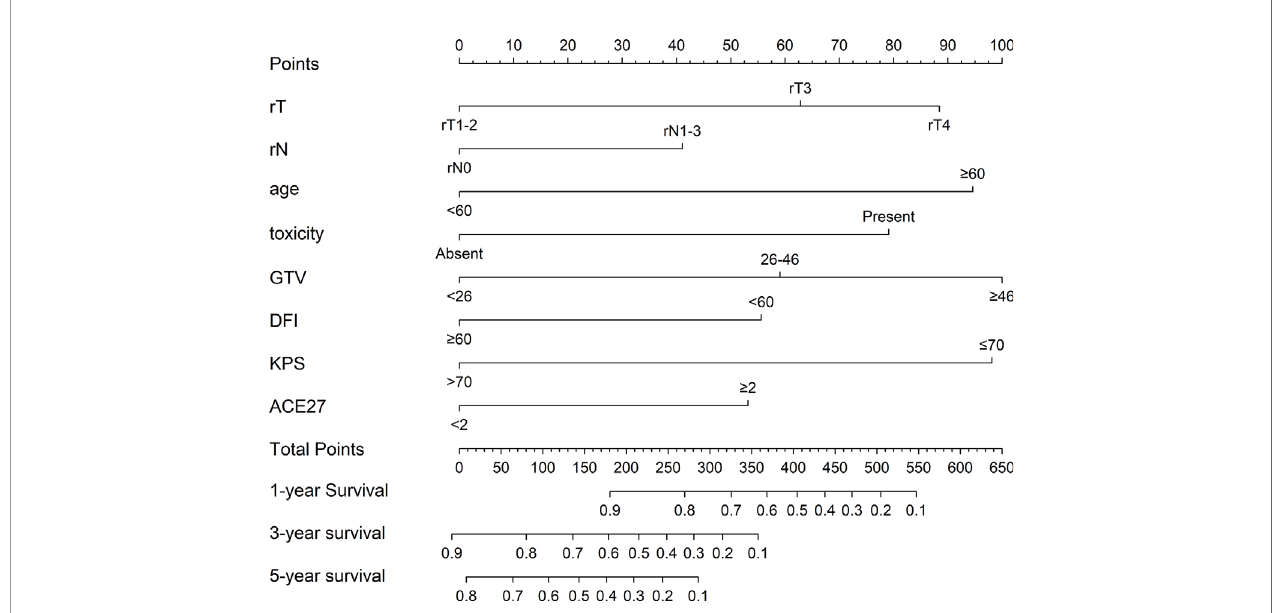
FIGURE 3 | Prognostic nomogram for locally recurrent nasopharyngeal carcinoma (lrNPC) patients: a line was drawn straight down to predict the 1-, 3-, or 5-year overall survival. rT, recurrent T stage; rN, recurrent N stage; toxicity, prior RT-induced grade ≥ 3 toxicity; GTV, gross tumor volume; DFI, disease-free interval; KPS, Karnofsky Performance Status; ACE-27, Adult Comorbidity Evaluation-27.